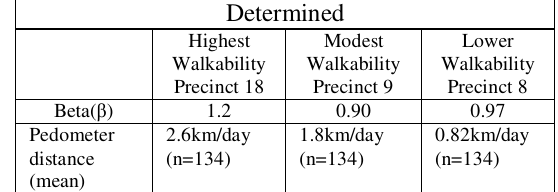
Fig. 7: Modest Walkability Precinct 9’s Link Node (cid:9)69 = 0.90 β = (cid:9)7: